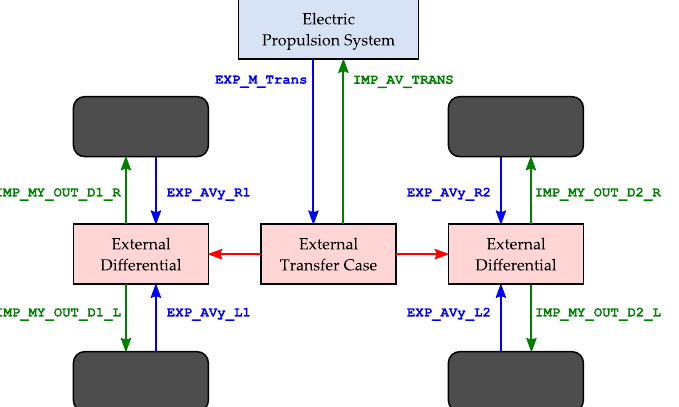
Figure 6. CarSim ® dataset configuration: four independent torque signals. Involved variables are indicated.